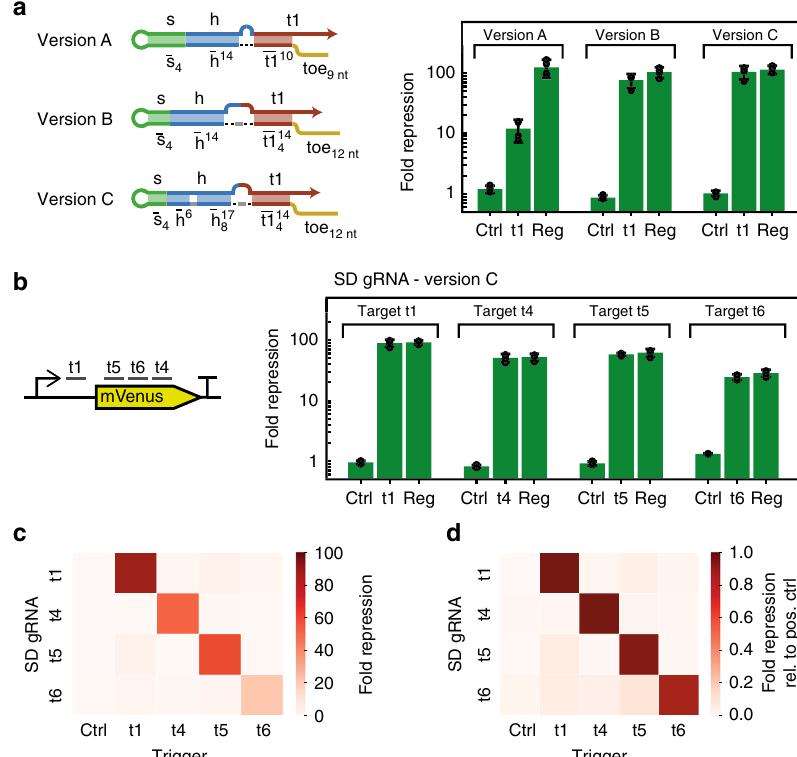
Fig. 5 Transcriptional regulation via SD gRNAs and dCas12a in E. coli . a Repression of mVenus fl uorescence by different versions of target-based SD gRNAs in E. coli with and without the expression of a cognate trigger. The design of the different versions is shown on the left. Version A is identical to the target- based SD gRNAs shown in Fig. 3. Expression of the dsDNase inactive mutant dCas12a is induced with IPTG and the fl uorescence per OD at 4 h after induction is compared with the fl uorescence per OD of uninduced cells containing the same SD gRNA plasmid and no cognate trigger. A regular dCas12a gRNA is used as a positive control for repression (ctrl: control trigger, t1: cognate trigger, reg: regular gRNA) ( N = 4, t -distribution two-sided 90% con fi dence interval). b Fold repression by the SD gRNA version C design for four different target sequences on the mVenus gene at 4 h after induction (ctrl: control trigger, t1-t6: cognate triggers, reg: regular gRNA) ( N = 4, t -distribution two-sided 90% con fi dence interval). c Crosstalk between different SD gRNAs and their triggers at 4 h after induction ( N = 4). d Crosstalk between different SD gRNAs and their triggers at 4 h after induction normalized by the fold repression of the respective positive control gRNA. ( N = 4) Source data are provided as a Source Data fi